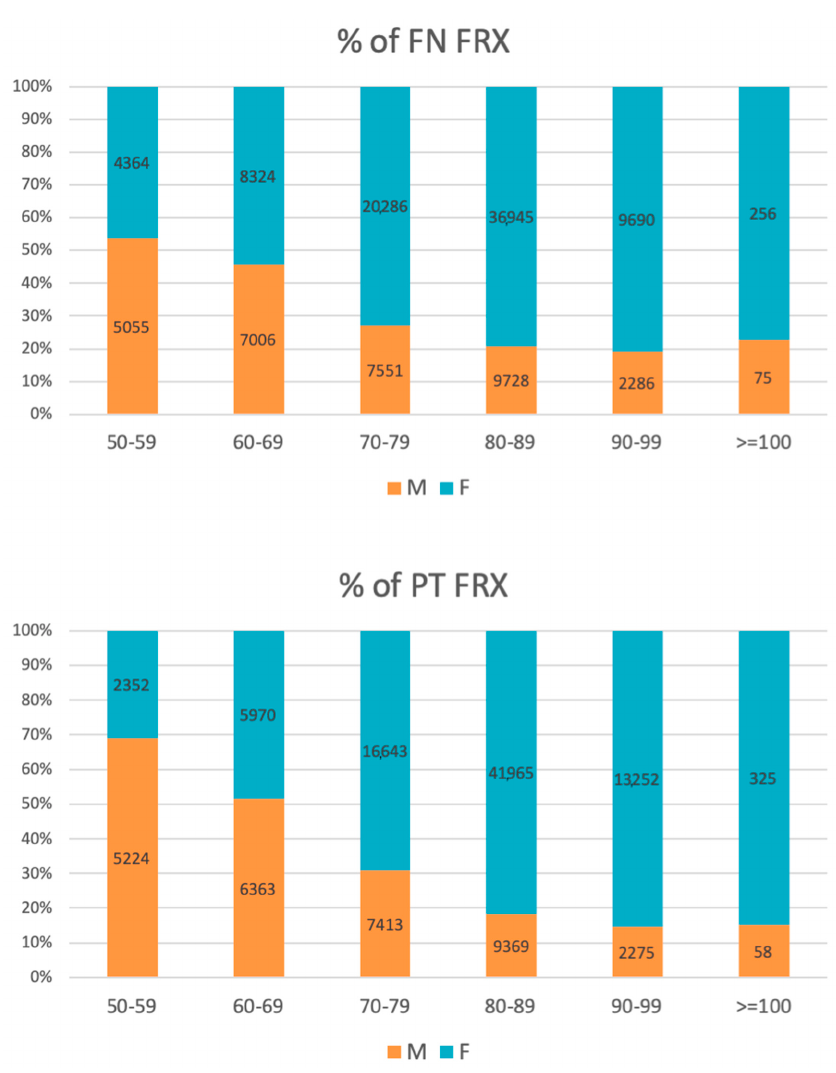
Figure 3. Percentage of the femoral neck (FN) and pertrochanteric (PT) fractures in all age groups (number of patients placed in bars).